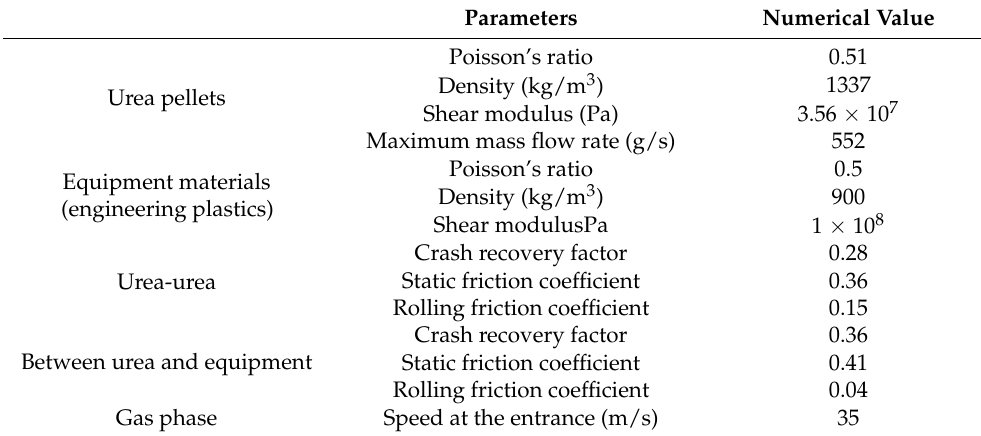
Table 6. EDEM parameter